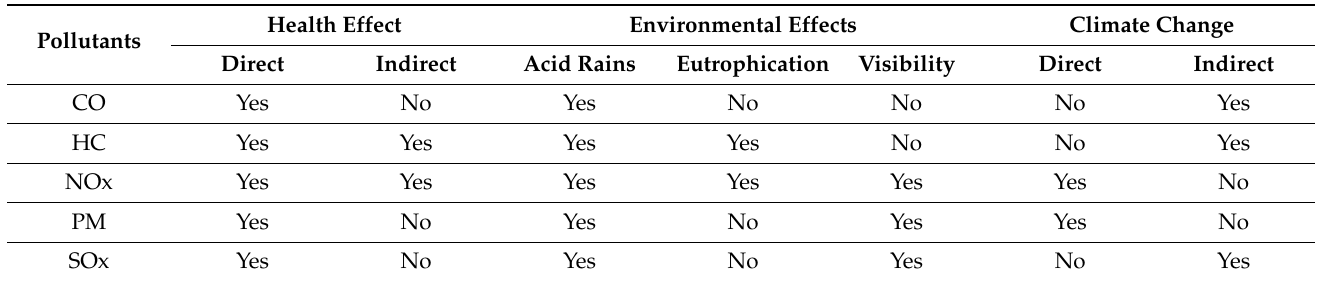
Table 1. Effects from pollutants on humans, environment, and climate.